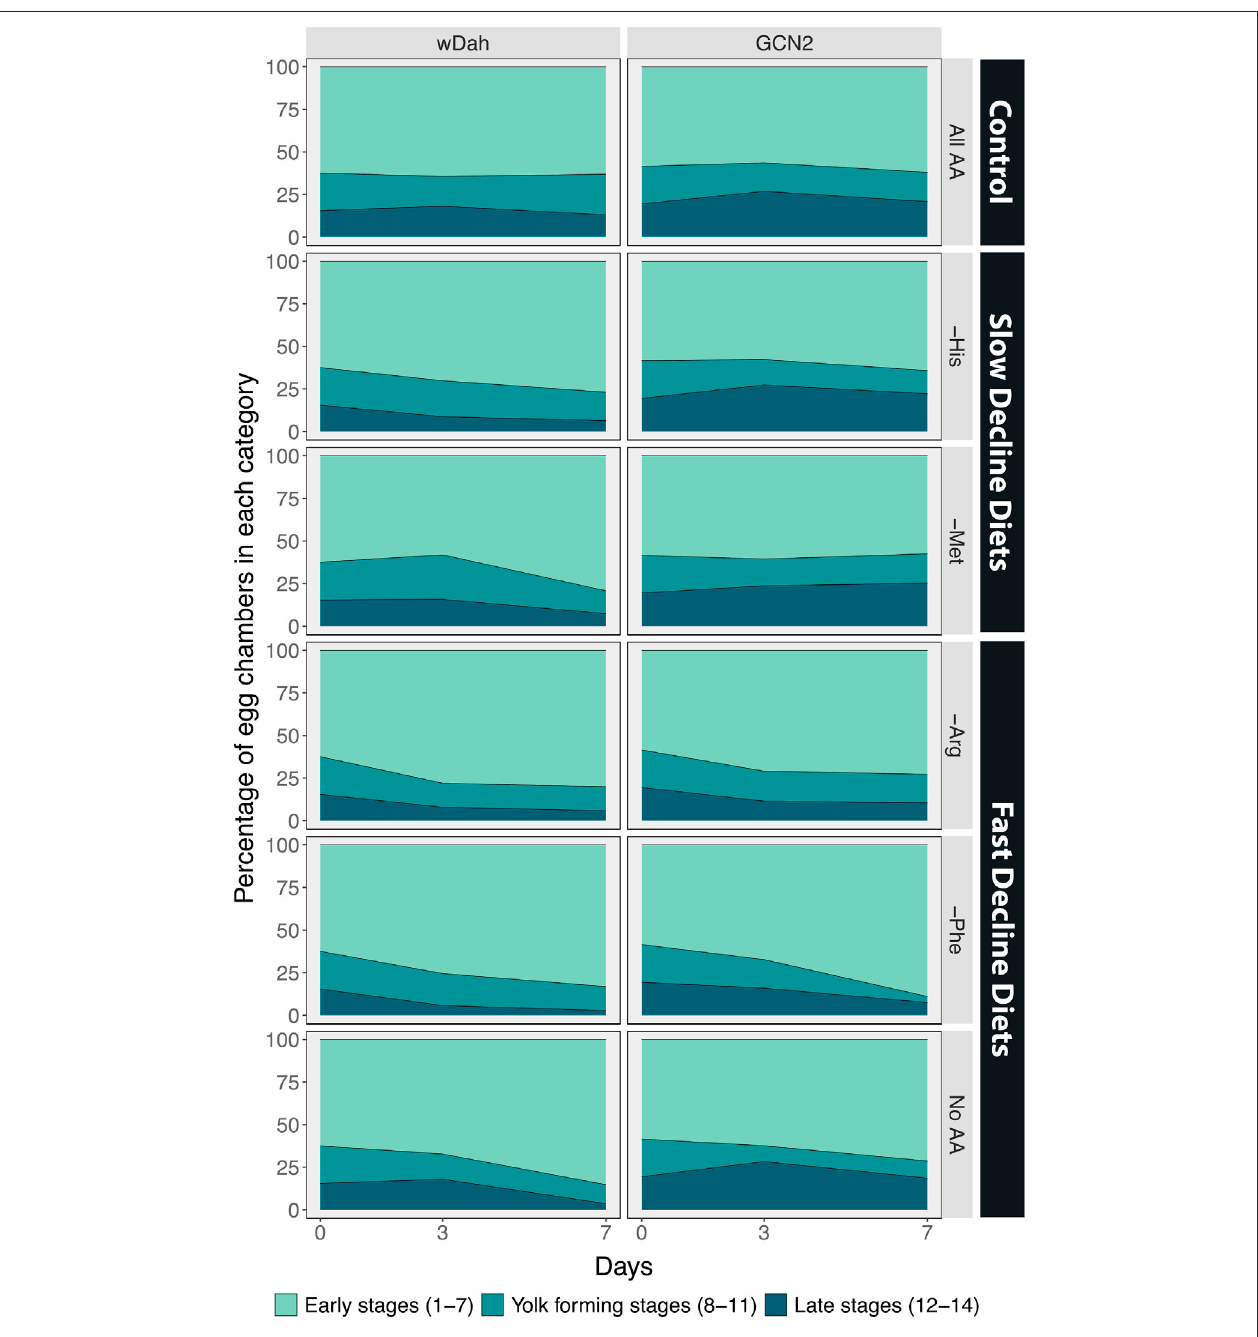
FIGURE 6 | The percentage of egg chambers in each category is affected by diet, and these effects are partially mediated by GCN2 signalling. Comparison between the percentage of egg chambers between white Dahomey (wDah) and GCN2 Δ fl ies.